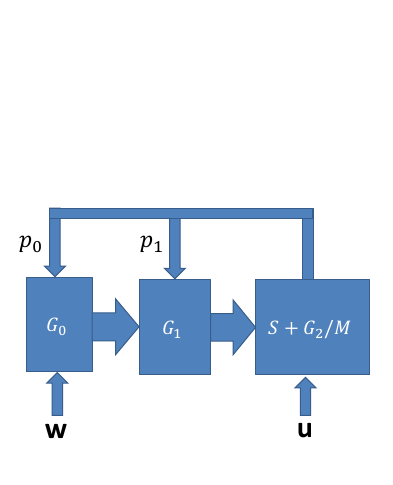
Fig. 3 A 3-compartment model with cytotoxic and recruiting